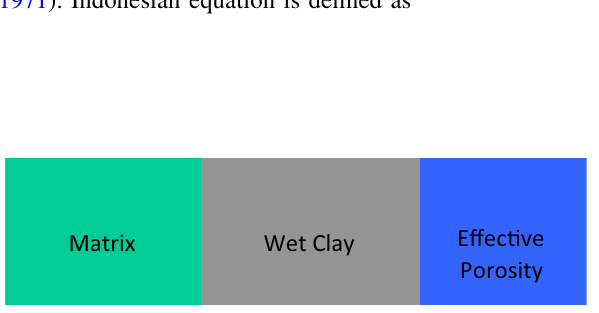
Fig. 11 Schematic diagram of volume of clay from density and neutron cross-plot Fig. 12 The display of ‘effective porosity and wet clay’